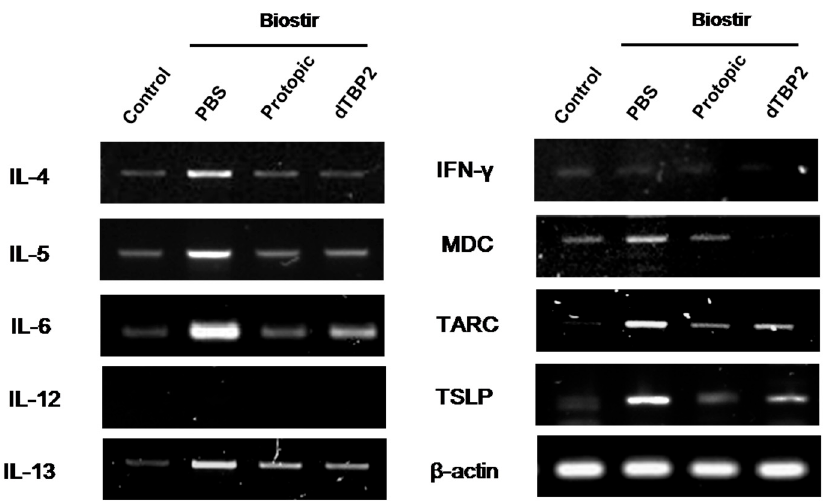
Figure 4. dTBP2 inhibits the cytokines/chemokines related to the pathogenesis of atopic dermatitis in house dust mite-induced AD mouse model. Total RNA was isolated from dorsal skin using a Trizol reagent kit according to the manufacturer’s instructions. Cytokine mRNA was analyzed by RT-PCR using specific primers for IL-4, IL-5, IL-6, IL-12, IL-13, IFN- γ , MDC, TARC, TSLP, and β -actin. PCR products were resolved on a 1.5% agarose gel and visualized with ultraviolet light after SYBR green-safe staining. This experiment was performed in triplicate.